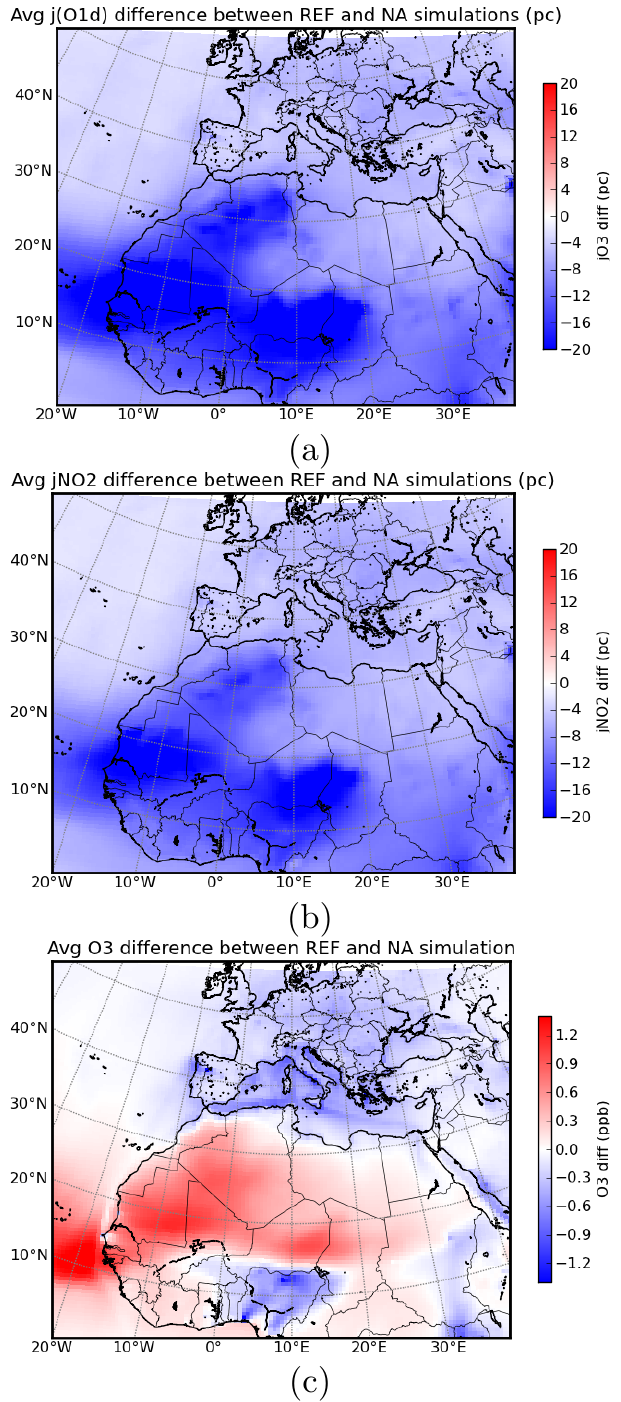
Figure 18. (a) Average difference of J( O 1 D ) between REF and NA (%) for all the simulation period (6 June–15 July); (b) average dif- ference of J( NO 2 ) between REF and NA (%) for the entire simula- tion period; (c) average difference of ozone concentration between REF and NA for all the simulation period (ppb).